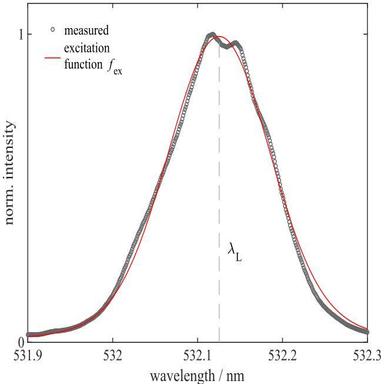
Measured spectral intensity distribution of the laser from S2 and the fit to the data approximated by a single Voigt function with parameters λL = 532.12 nm, σS2 = 0.065 nm and γS2 = 0.014 nm (about 5 cm− 1 FWHM).